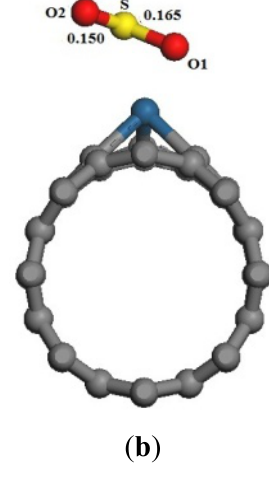
-Pt-SWCNT adsorptive system. ( a ) Front view; 2